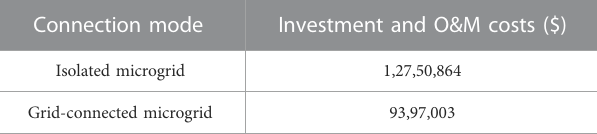
TABLE 7 Total investment and O&M costs of the industrial microgrid in both